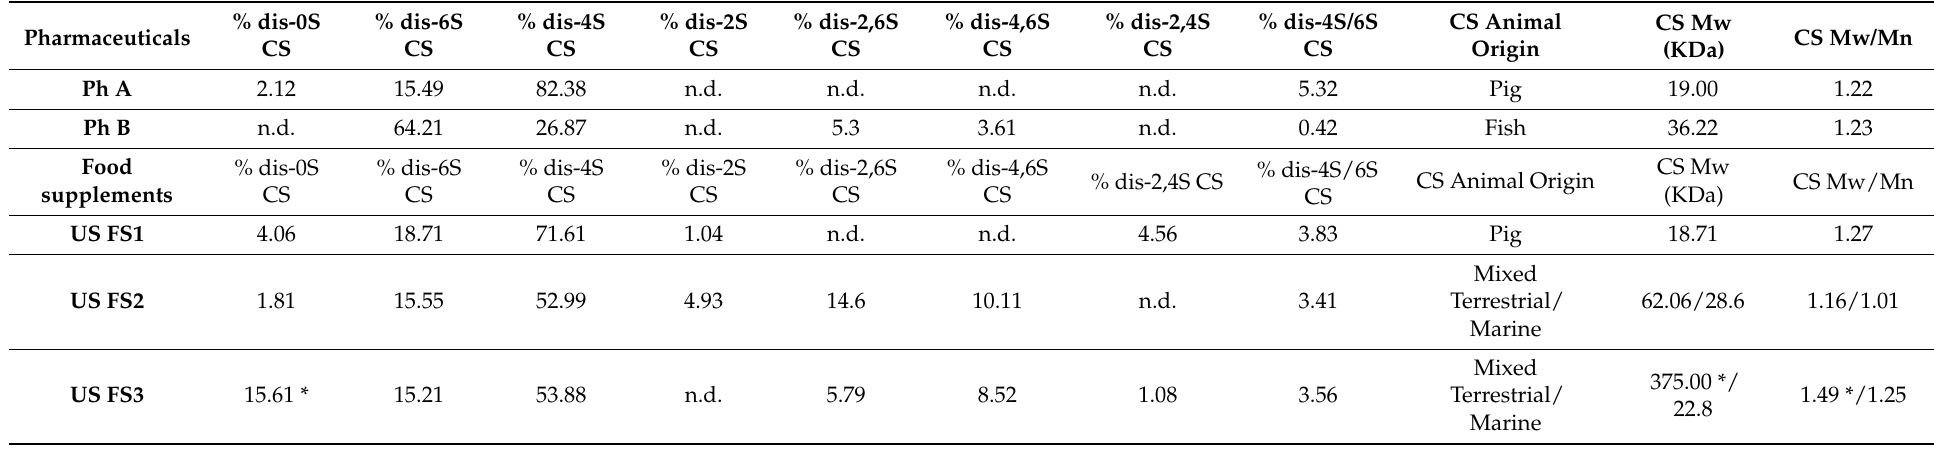
Table 2. CS disaccharide composition and animal origin determined by HPCE analyses after enzymatic digestion, CS average molecular weight and polydispersity index as determined by SEC-TDA analyses of pharma grade samples and US food supplements (standard were deviations lower than 5%).